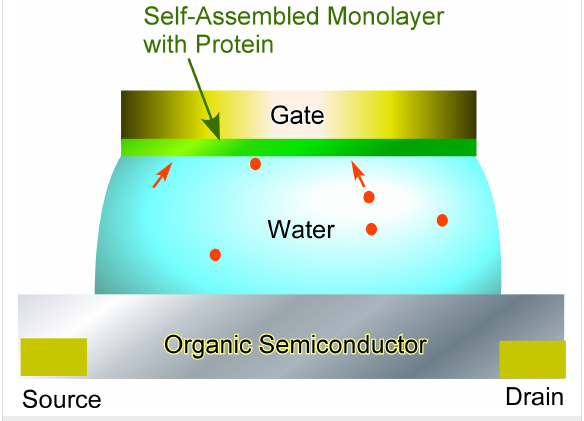
Figure 3: Highly sensitive humidity sensor based on a triboelectric nanogenerator device where nanochannels in the membrane adsorb moisture, which results in the generation of internal